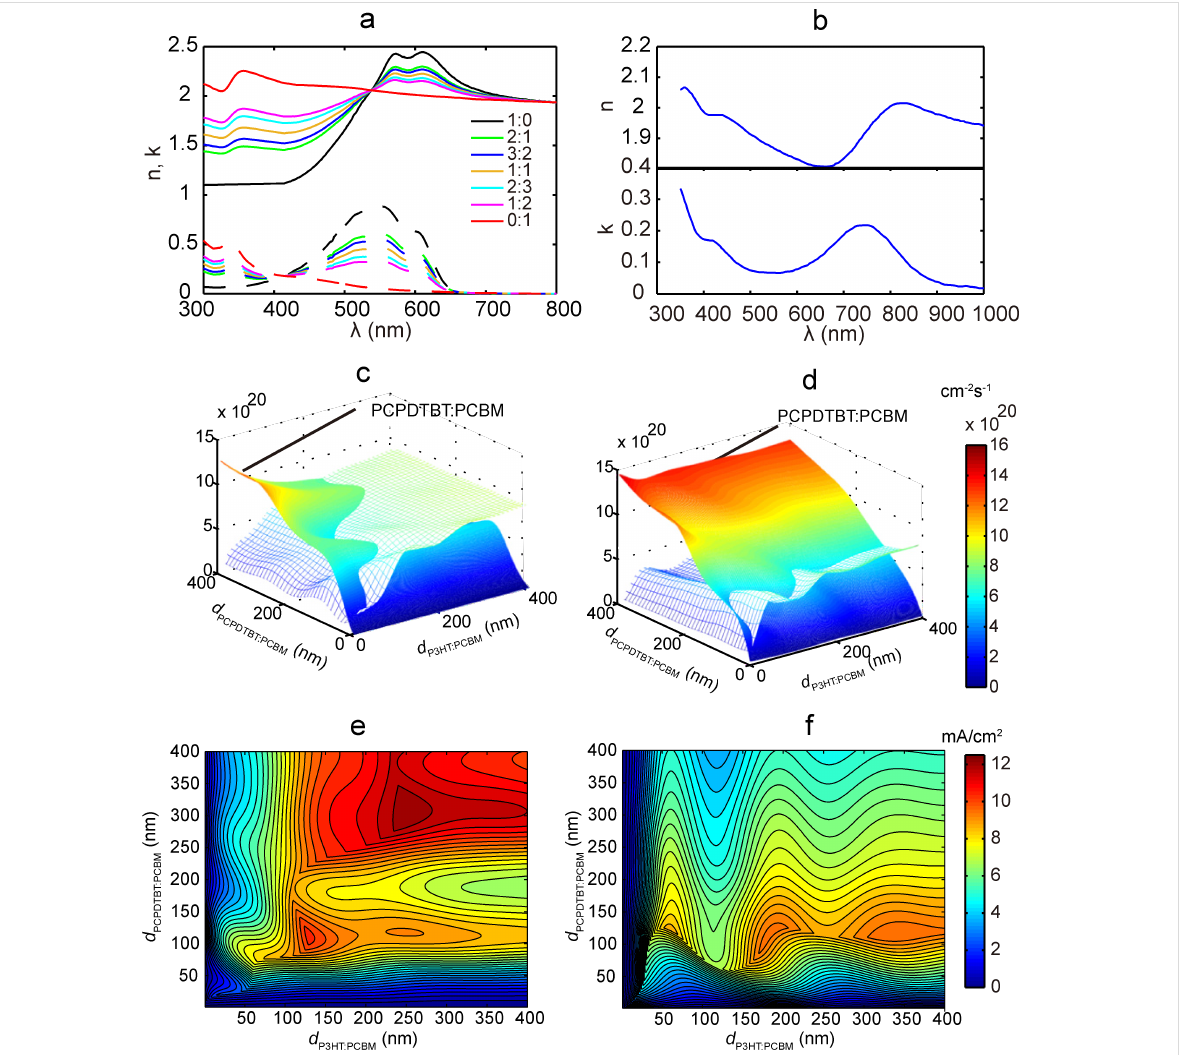
Figure 3: Optical parameters and simulation results from the optical calculation module. The complex refractive index of the P3HT/PCBM blend (a) with different D/A weight ratio (the solid lines are for n , and the dashed lines are for k ) and PCPDTBT/PCBM (b) with weight ratio of 1:2. (c) and (d) (sharing the same color code scale) present the photon absorption efficiency calculated for configuration A and B, respectively. The weight ratios of P3HT/PCBM and PCPDTBT/PCBM active layers are 1:1 and 1:2. The maximum photocurrent estimated according to the photon absorption effi- ciency for the two device configurations is displayed in (e) and (f) (e and f share the same color code scale).